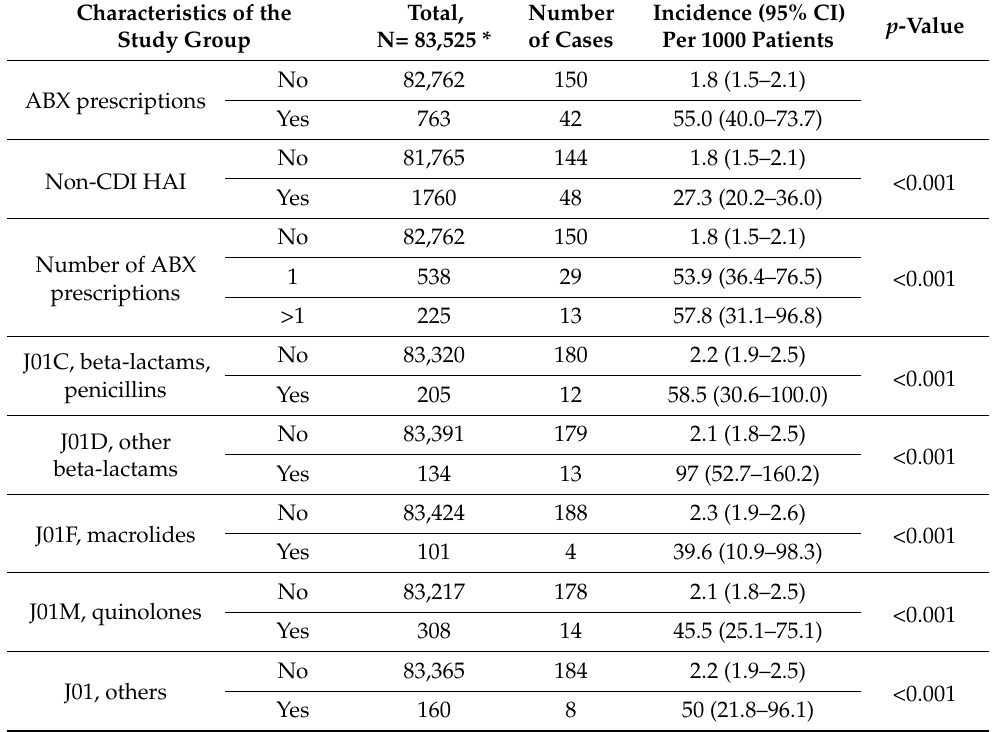
Table 2. Antibiotic prescriptions in the post-discharge period in ambulatory care.